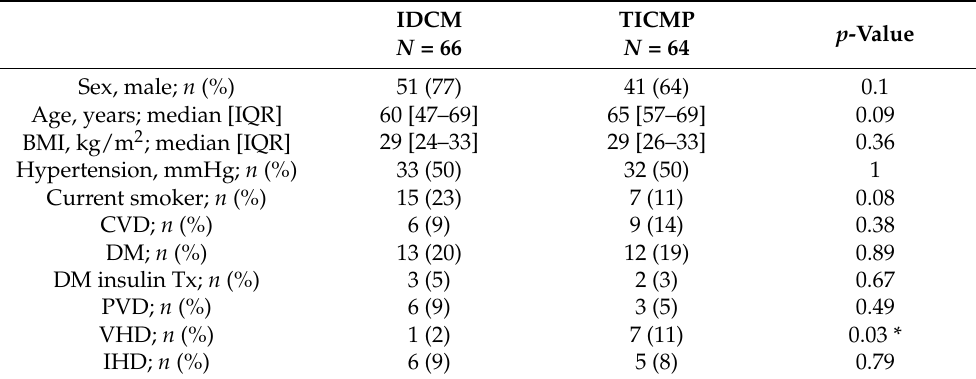
Table 1. Baseline demographic characteristics and